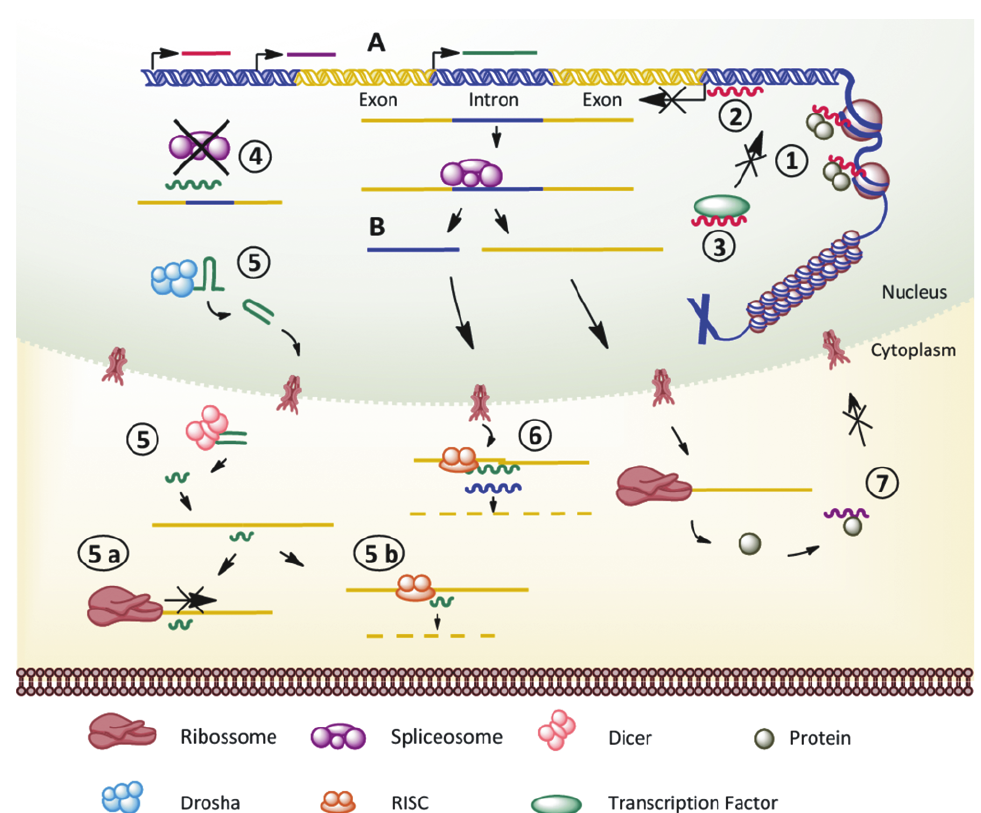
Fig. 1 – Main described mechanisms of ncRNA action in the cell. Pre-transcriptional mechanism: (1) ncRNAs acting on protein complexes that are involved in chromatin remodeling lead local regulation of gene expression; (2) ncRNA forms a triplex at the promoter region of genes and inhibits gene transcription; (3) ncRNA interacts with transcription factors and acts as co-repressor or co-activator of transcription (modulates protein activity). Post-transcriptional mechanism: (4) ncRNA may act at the spliceosome interfering in the splicing process; (5) ncRNA may generate miRNA (by the processing steps involving Drosha and Dicer) and either (5a) Inhibit mRNA translation, or (5b) Degrade mRNA target by RISC; (6) ncRNA may act as endogenous small-interfering RNA (siRNA) and be cleaved by RISC. Post-translation mechanism: (7) ncRNA may interact with target proteins altering protein localization and organizational role in the cell. Biosynthesis of ncRNA: (A) ncRNA may be generated by independent transcription, or (B) ncRNA may be generated from spliced introns of protein-coding